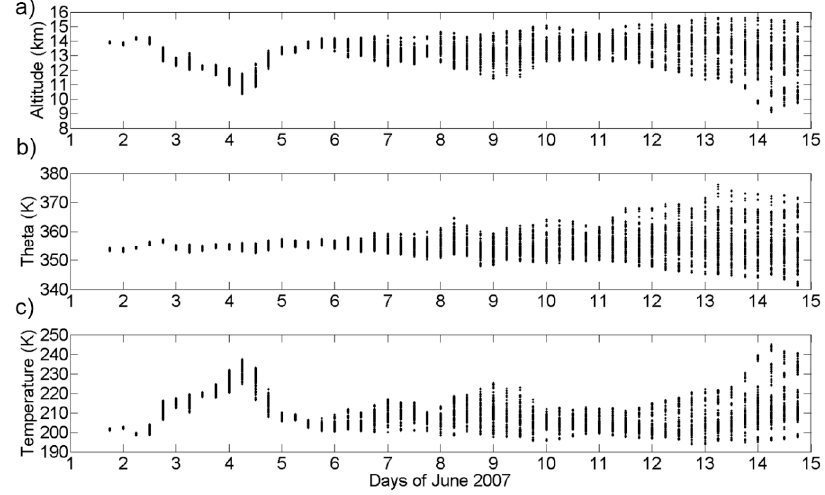
Figure 5. Temporal evolution of ( a ) altitude (in km, deduced from pressure level) and thermodynamic parameters; ( b ) theta (in K); and ( c ) temperature, interpolated on LACYTRAJ forward trajectories points during 15 days (1 to 15 June 2007).